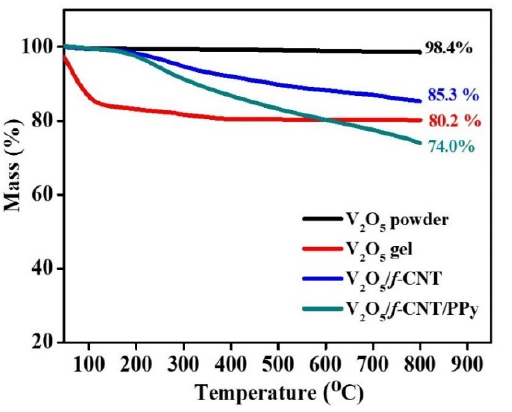
Figure 4. TGA thermograms of V 2 O 5 powder, V 2 O 5 gel, V 2 O 5 / f -CNT, and V 2 O 5 / f -CNT/PPy.